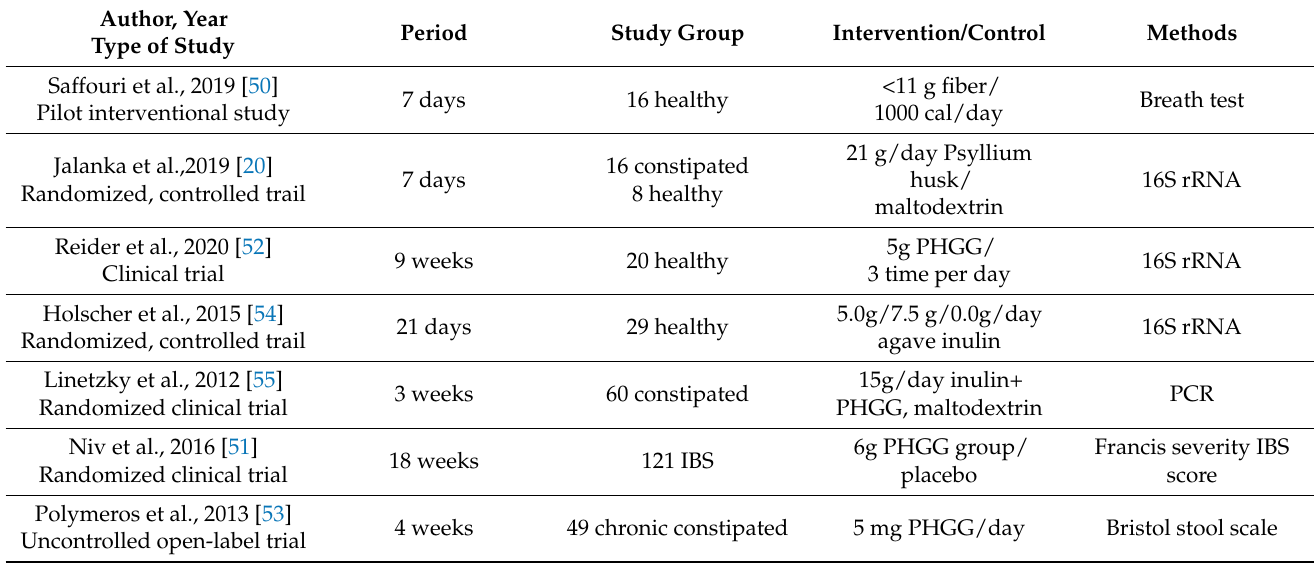
Table 4. Characteristics of included studies connected with fiber.